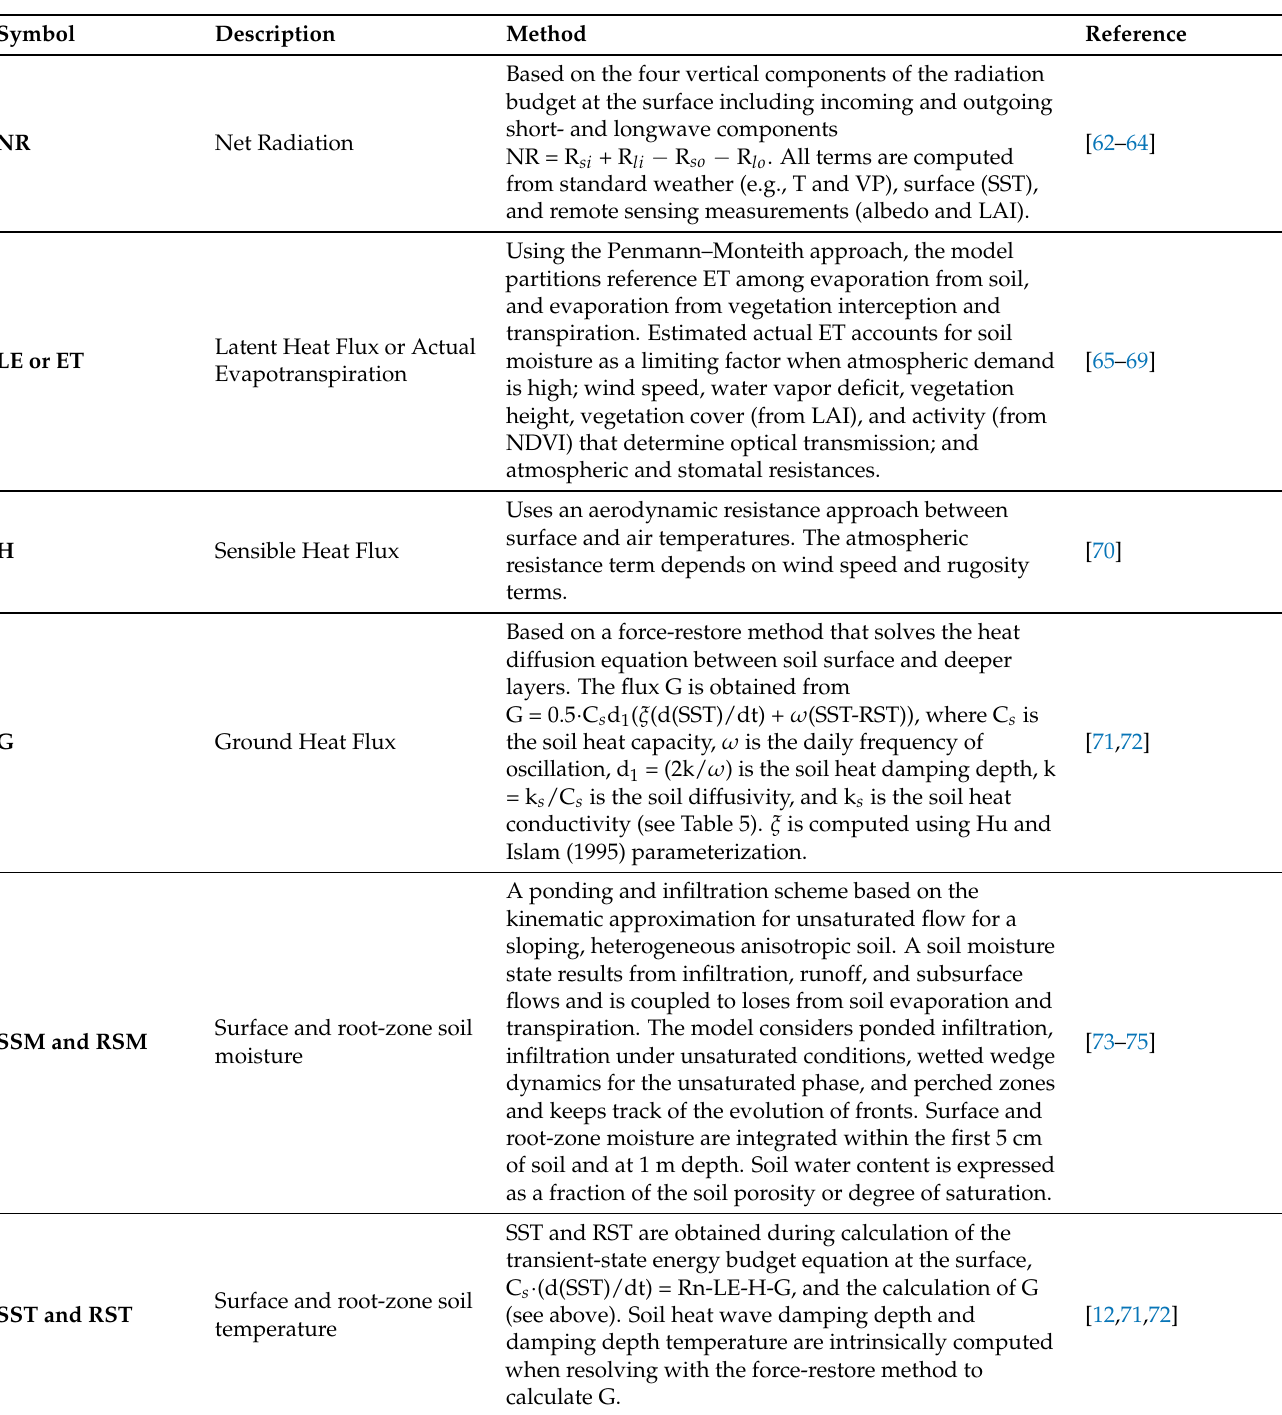
Table 3. Tin-based Real-time Integrated Basin Simulator (tRIBS) model of the physics of energy fluxes and soil status including mathematical framework and reference